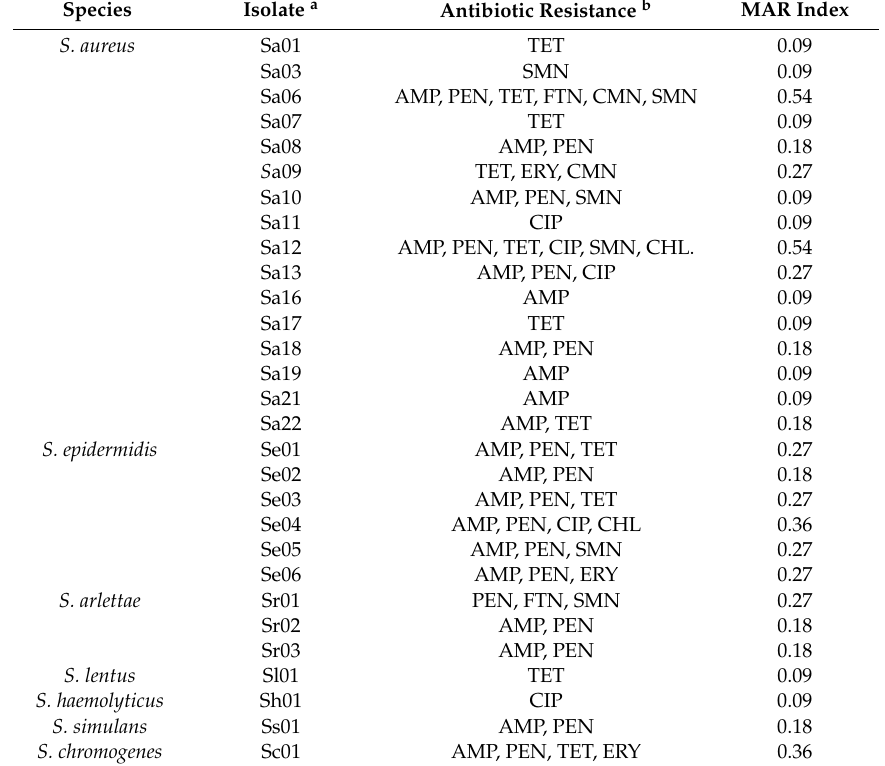
Table 3. Multiple antimicrobial resistance (MAR)